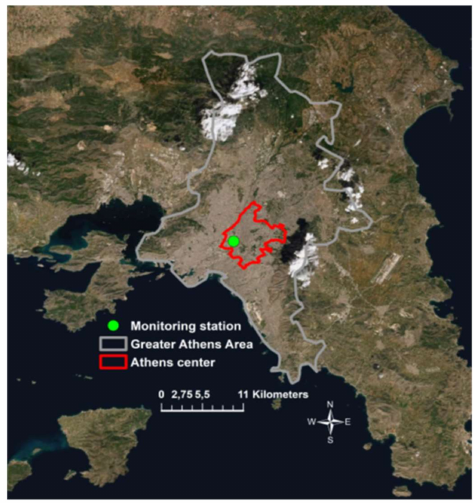
Figure 1. The location of the sampling